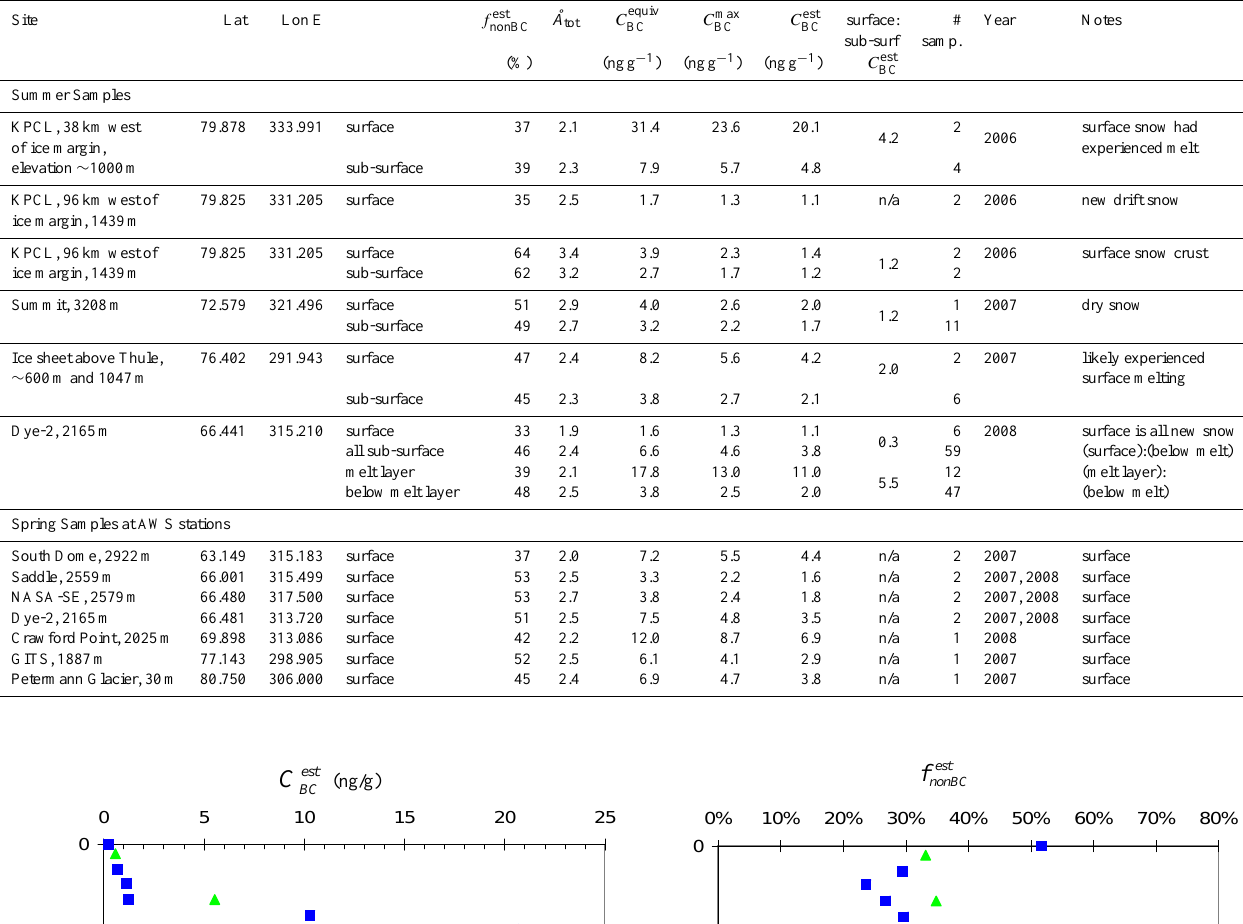
Table 6. Median values for samples from Greenland, with medians for surface and sub-surface samples calculated separately. Three Dye-2 profiles which include a melt layer are further broken down by new surface snow, melt layer and below the melt layer. Site Lat